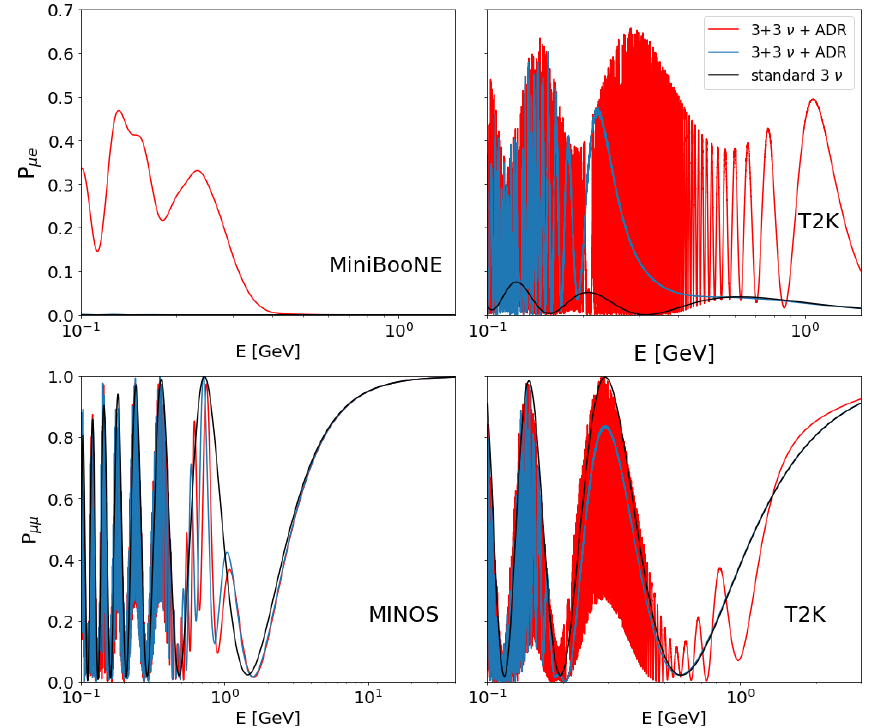
Figure 7 . Comparison between the predictions of the three-neutrino standard picture (black) and a 3+3 model with altered dispersion relations for ( (cid:15); (cid:20); (cid:17) ) = (4 : 9 ; 5 ; 5) (cid:2) 10 (cid:0) 17 (blue) and ( (cid:15); (cid:20); (cid:17) ) = (1 ; 5 ; 5) (cid:2) 10 (cid:0) 17